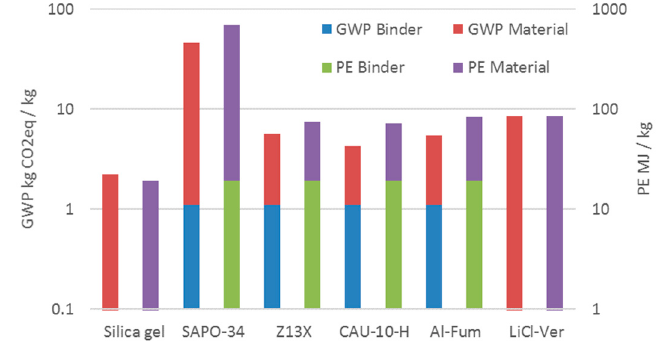
Figure 7. Environmental impact of the storage materials per kg of material (logarithmic scales).